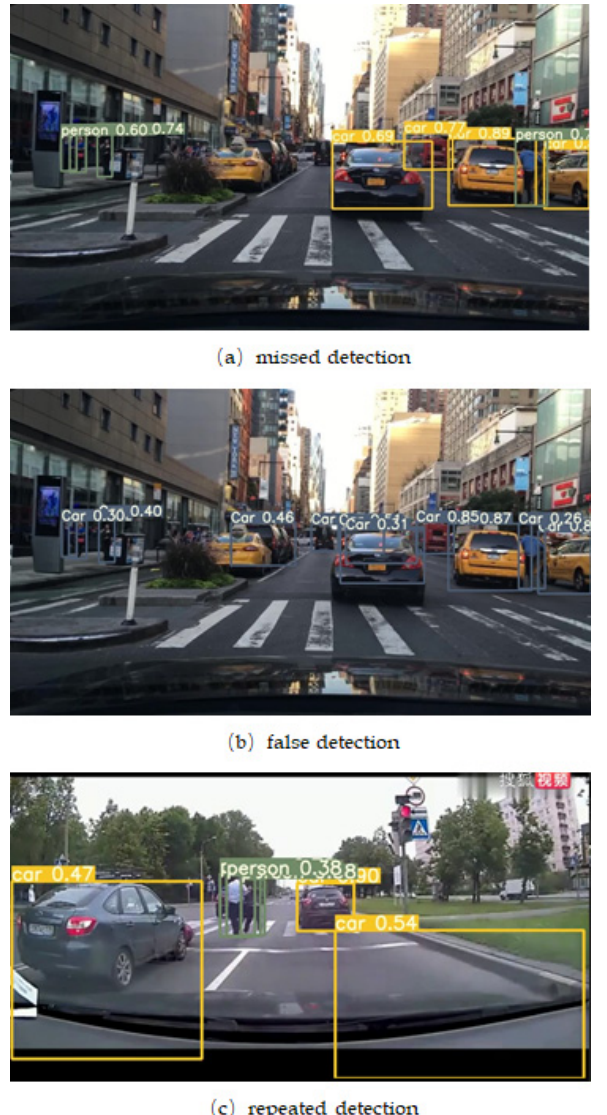
Figure 1. You Only Look Once version 3 (YOLOv3)’s detection effect on pictures and videos.